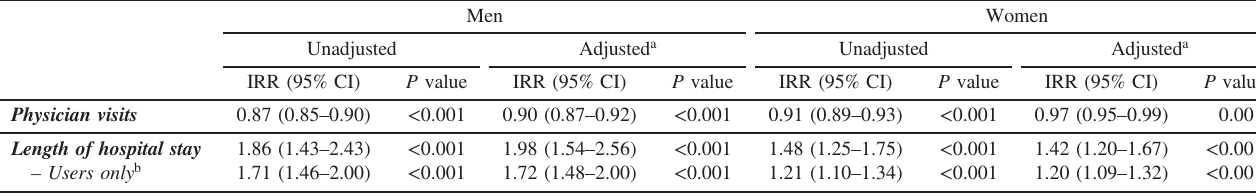
Table 3. Associations of low income with medical services utilization by gender